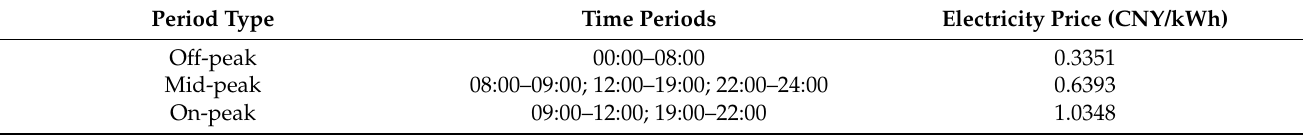
Table 1. Time-of-use (TOU) electricity tariffs implemented in Guangdong. Period